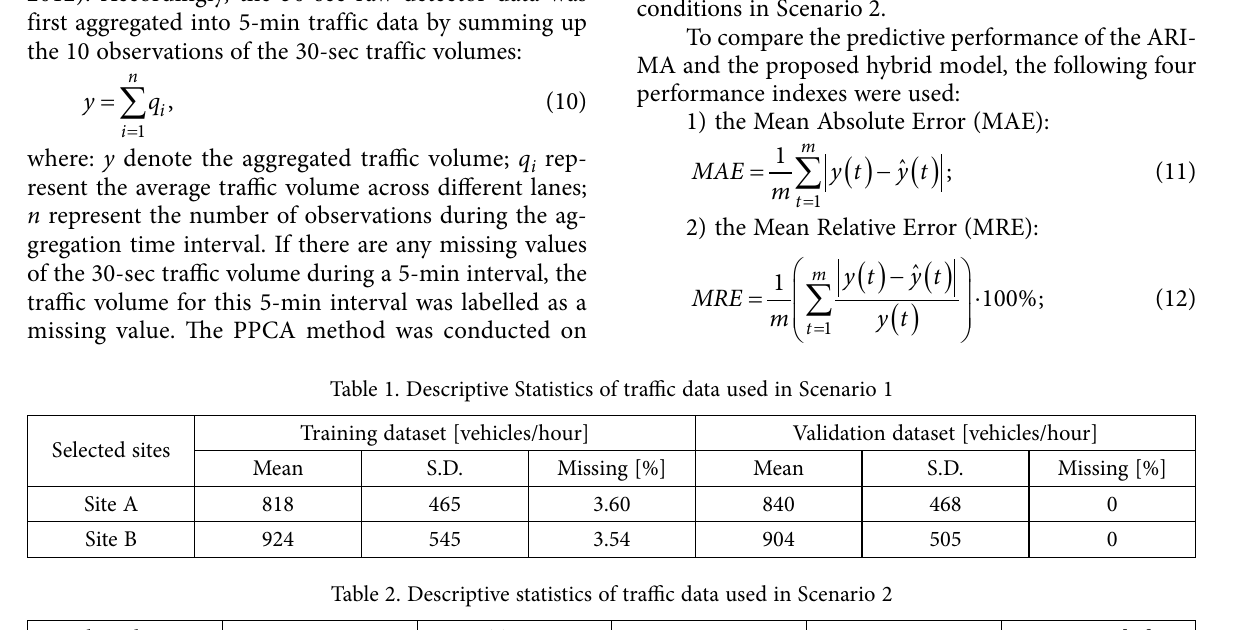
trafficSite B 32.36 mile